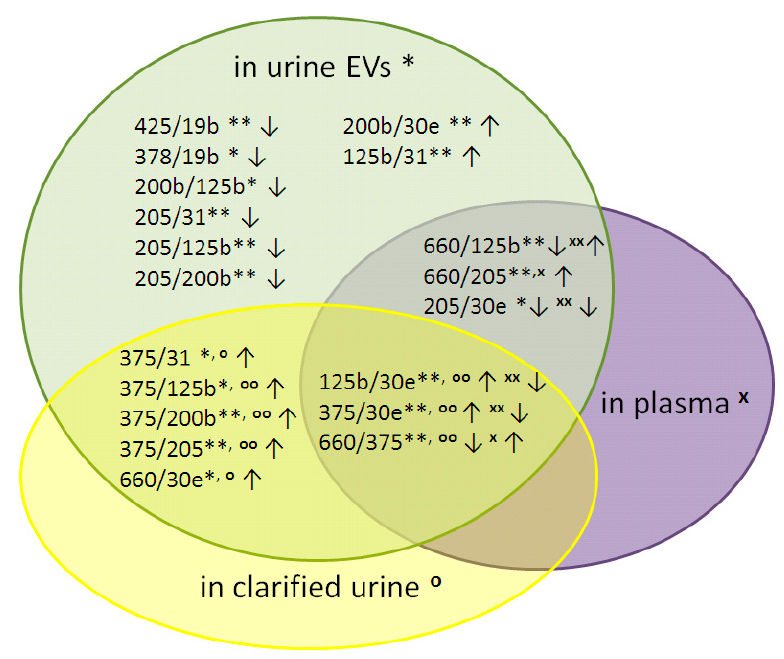
Figure 2. Euler–Venn diagram of the relative expression of the miRNAs in urine EVs, clarified urine (CU) and blood plasma. Arrows represent the ratio of the relative expression of the miRNA pairs before and after RP. Wilcoxon signed-rank test for different samples: Urine EVs, ** p < 0.01 and * p < 0.05; CU, oo p < 0.01 and o p < 0.05; blood plasma, xx p < 0.01 and x p < 0.05. Table 2. ddCt mean values for differentially expressed miRNA pairs after RP and before RP.